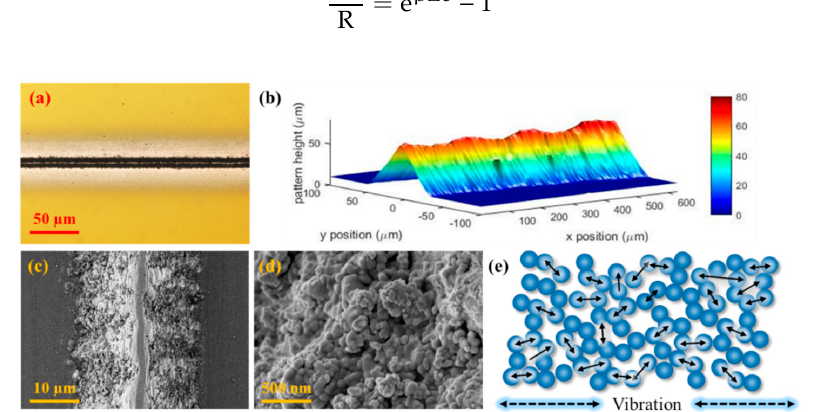
Figure 3. ( a , b ) The optical microscope image and confocal microscope image of the fabricated sensor, respectively. ( c , d ) The scanning electron microscopy (SEM) image and its magnified view of the fabricated sensor. ( e ) Schematic diagram of the sensing